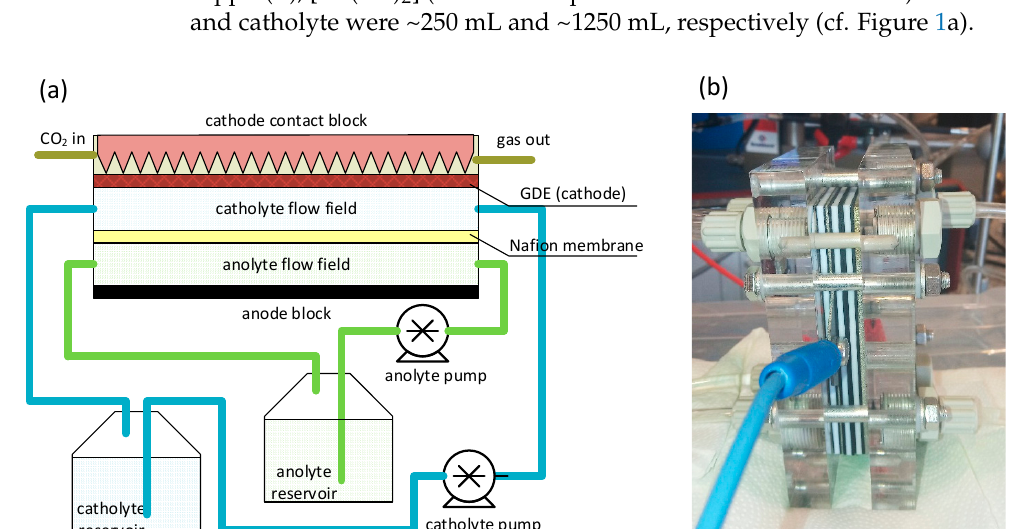
Figure 1. Scheme of the electrochemical GDE-based flow cell setup, including a cross-section of the cell ( a ) and a real photo of the cell ( b ).